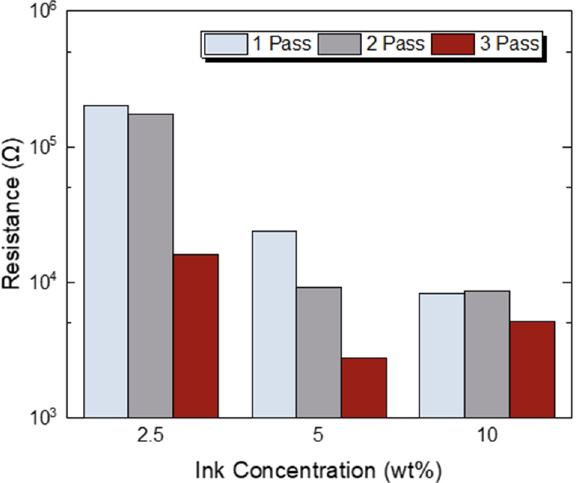
Figure 7. Four-point (4p) resistance as a function of f –rGO ink concentrations for different printing passes.